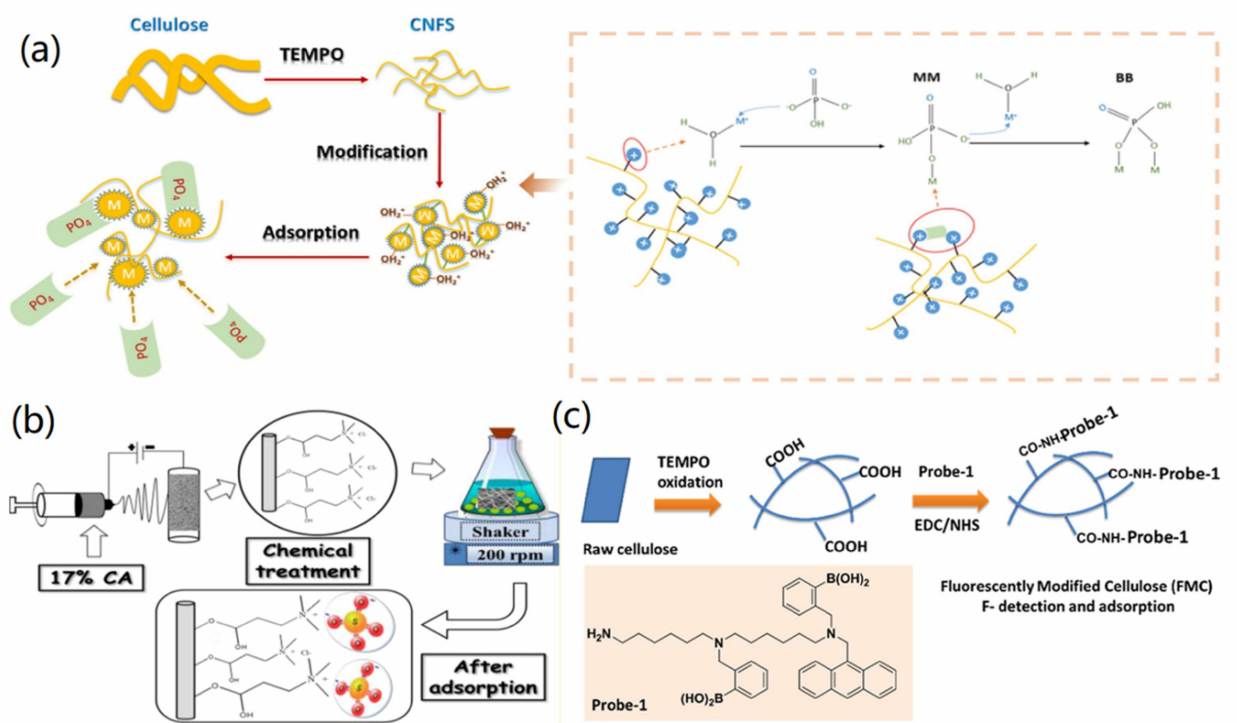
Figure 6. CNF-based adsorbents for the removal of anion ions: ( a ) Removal of PO 43 − . Reprinted with permission from Ref. [76], Copyright 2016, Elsevier Ltd. ( b ) Removal of SO 42 − . Reprinted with permission from Ref. [78], Copyright 2017, American Chemical Society. 2016. ( c ) Removal of F − . Reprinted with permission from Ref. [80], Copyright 2018, Elsevier